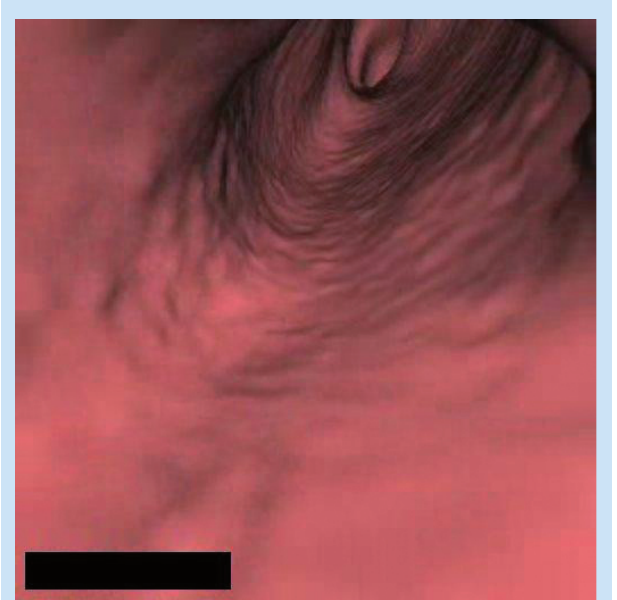
Fig. 4. Example of a polyp.